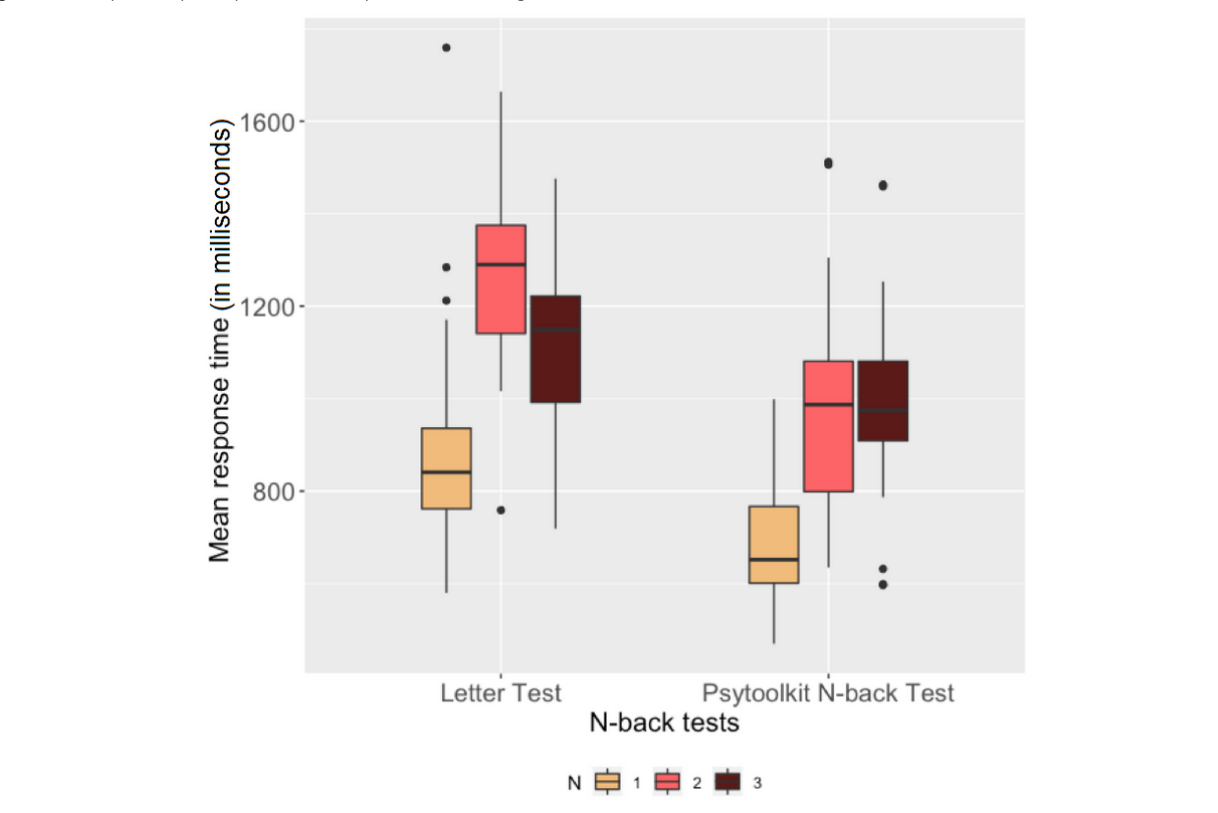
Figure 9. Box plots of participants' mean response times during the N-back